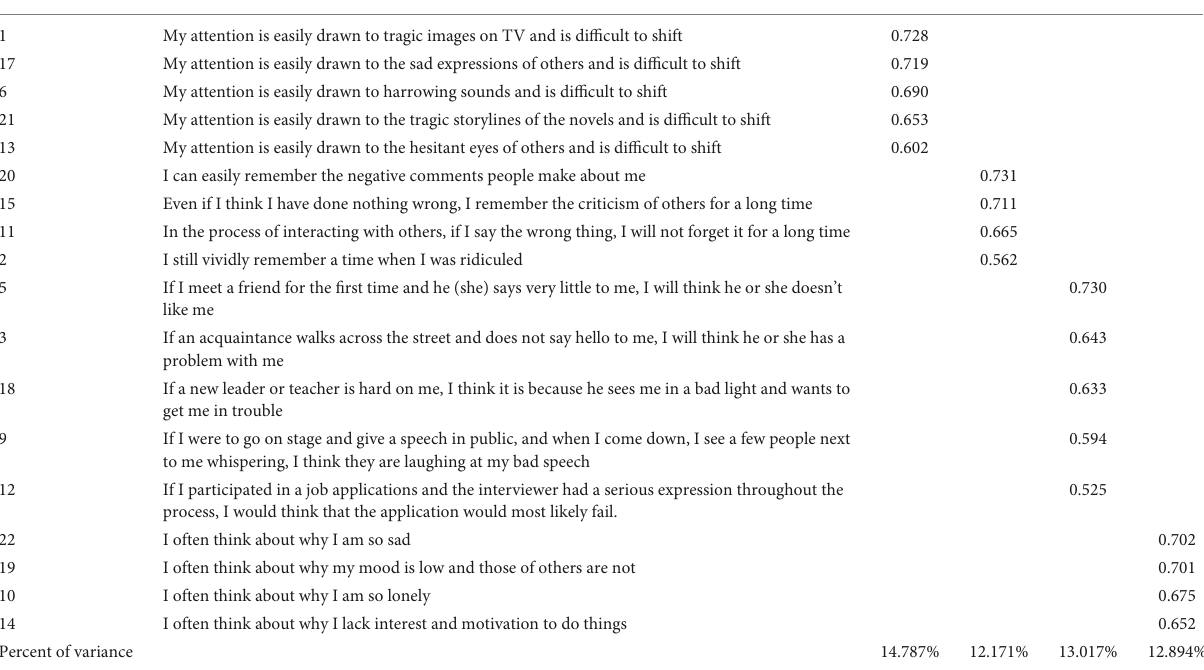
TABLE 4 Standardized factor loading of the negative cognitive processing bias